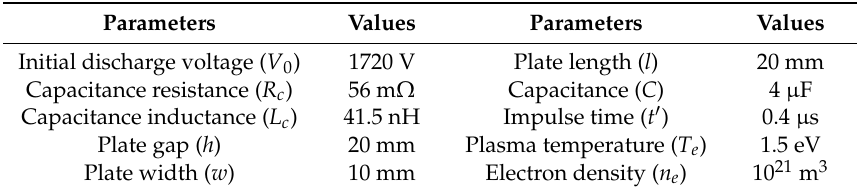
Table 2. Operation parameters of µ PPT by Coletti [19].